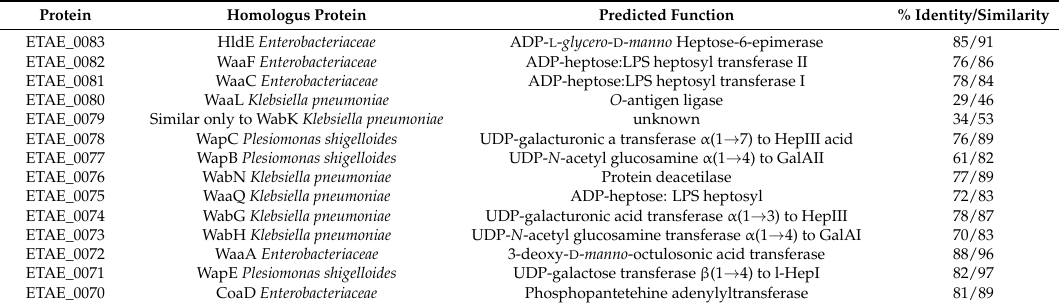
Table 2. Characteristics of the proteins encoded from E. tarda EIB 202 waa